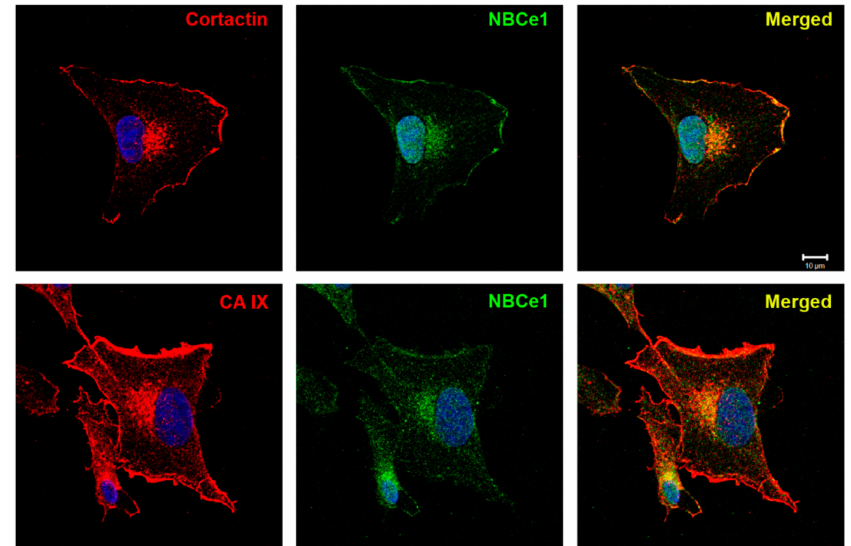
Figure 2. CAIX colocalizes with bicarbonate transporter NBCe1 in HT1080 cells seeded on collagen. After 5h of invadopodia assembly in 2% hypoxia, the samples were stained for NBCe1 and cortactin ( A ) and NBCe1 together with CAIX ( B ). Nuclear DAPI staining is blue. Confocal microscopy analysis revealed the occurrence of bicarbonate transporters within invading cells and their colocalization with CAIX and the invadopodial marker cortactin. The coincident distribution of both mentioned protein pairs was observed in the close proximity to the